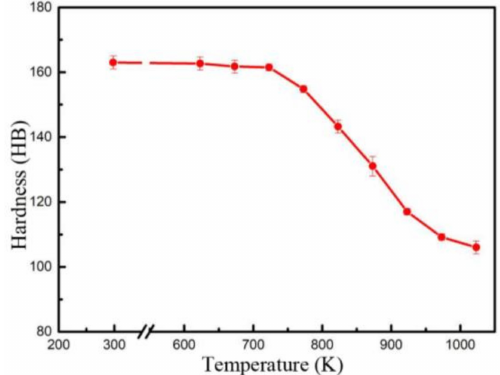
Figure 2. The hardness of the Cu-Cr-Zr alloy as a function of the peak age samples after annealing at different temperatures for 60 min.